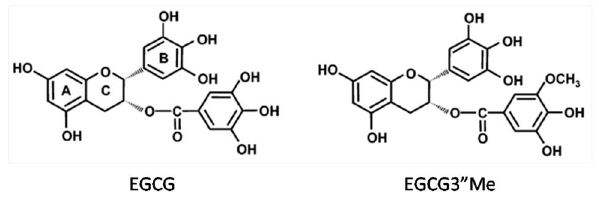
Figure 1. Chemical structures of EGCG and EGCG3’’Me isolated from tea leaves. EGCG has flavan-3-ol structure with A and B rings and a D-galloyl group. EGCG3’’Me contains a methyl ether group at the 3 0 position of the D ring.